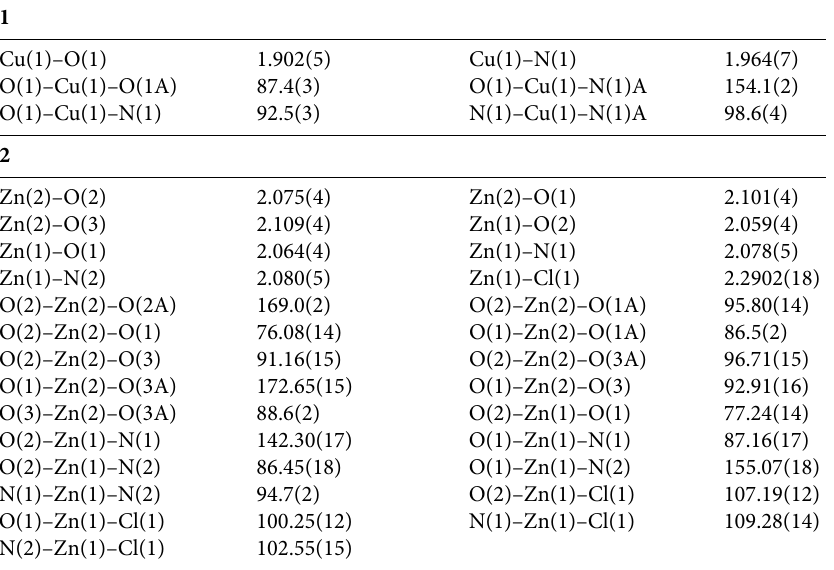
Table 2. Selected bond distances (Å) and angles (°) for the